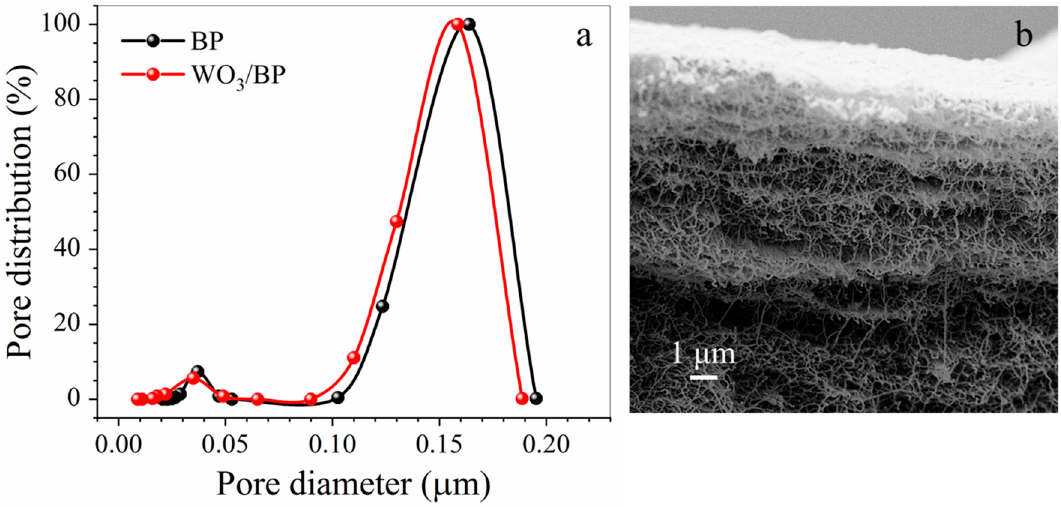
Figure 4. ( a ) Pore size distribution of both a BP membrane (black dots) and a WO 3 /BP photocatalytic membrane (red dots); ( b ) SEM cross section picture of a WO 3 /BP